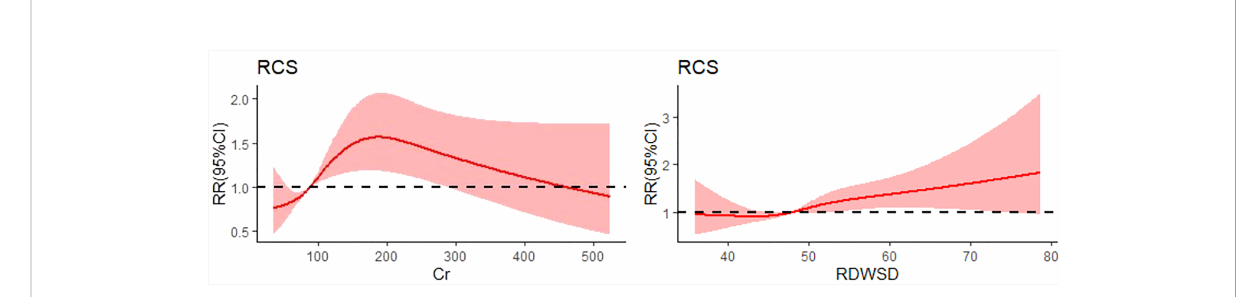
FIGURE 7 Restricted cubic spline plot of the relationship between readmission and in fl uencing factors in heart failure patients within 6 months. (RDWSD: standard deviation of red blood cell distribution width).